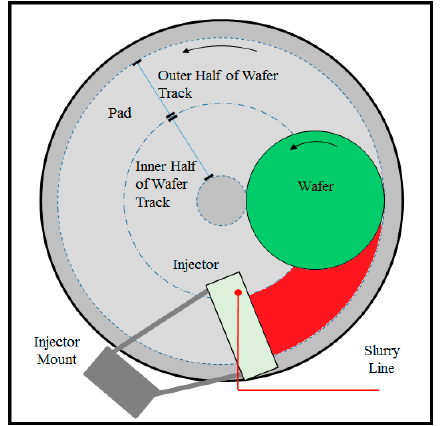
Figure 5. Coverage of fresh slurry on wafer track (red) using slurry injection system with slurry injection point coinciding with the center of the wafer